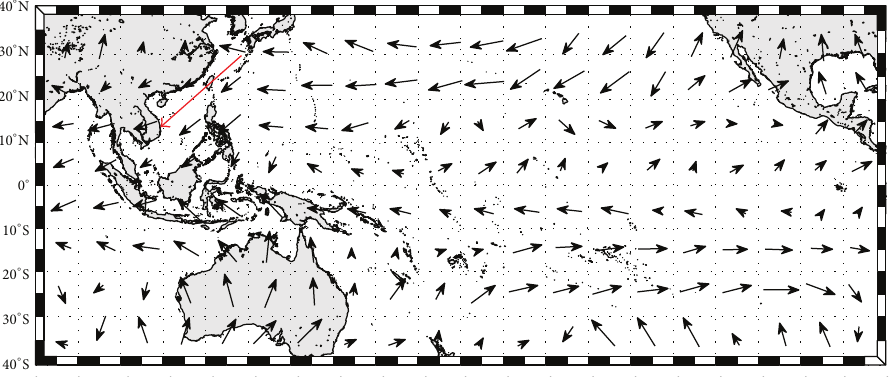
Figure 6: Anomalous patterns of wind vector over the Western Pacific during El Nino Modoki episode. The red arrow indicates the wind direction near Taiwan (sketched based on Feng and Li